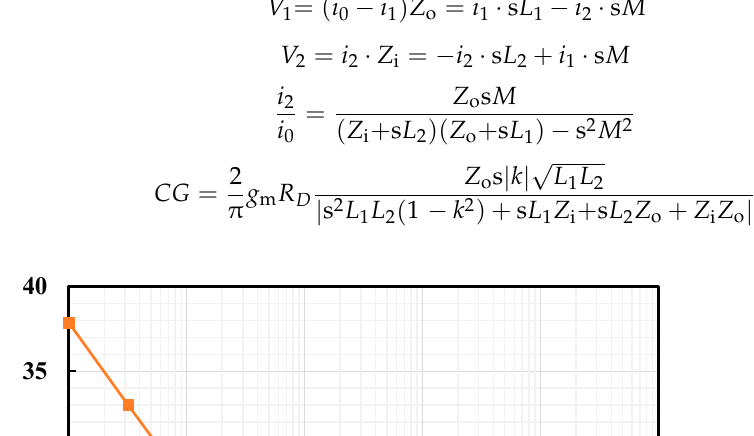
Figure 6. The schematic of the proposed double-balanced mixer.